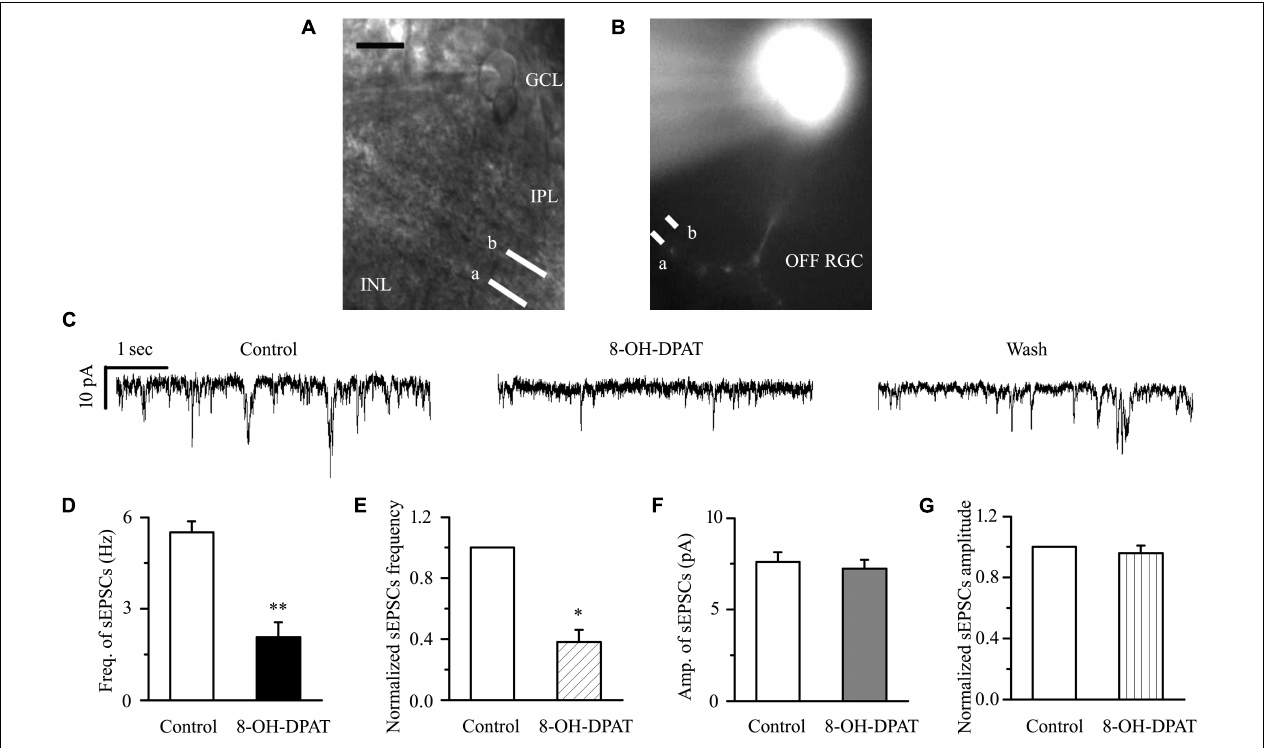
FIGURE 4 | 8-OH-DPAT significantly reduced the frequency, but not the amplitude, of glutamatergic sEPSCs in OFF-type RGCs. (A,B) The micrograph in (A) was taken with an infrared interferometric phase microscope, and the retinal layers can be seen. Representative Lucifer yellow-filled OFF-type RGCs with dendritic arborizations in the proximal (a) and distal (b) parts of the IPL are shown. GCL, ganglion cell layer; IPL, inner plexiform layer; INL, inner nuclear layer. Scale bar: 10 µ m. (C) Representative traces showing the effect of 10 µ M 8-OH-DPAT on glutamatergic sEPSCs. Vertical scale bar: 10 pA; horizontal scale bar: 1 s. (D) Summarized data from 11 RGCs showing that 10 µ M 8-OH-DPAT significantly decreased the average frequency of glutamatergic sEPSCs. (E) Normalized glutamatergic sEPSC frequency ( n = 11). (F) Summarized data from 11 RGCs showing that the average amplitude of glutamatergic sEPSCs was not significantly changed by 10 µ M 8-OH-DPAT. (G) Normalized glutamatergic sEPSC amplitude ( n = 11). ∗ p < 0.05 and ∗∗ p < 0.01 vs. control, Student’s paired t-